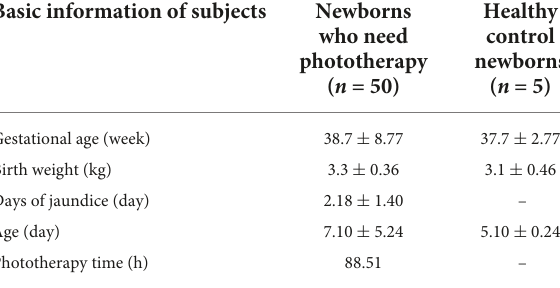
TABLE 1 Basic information. Basic information of subjects